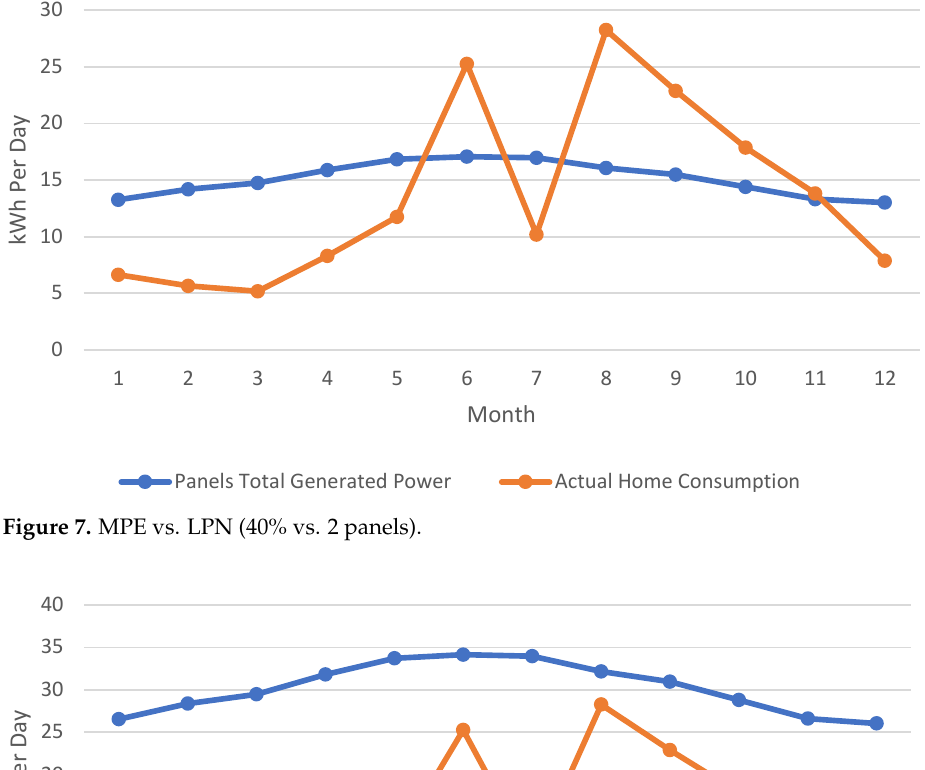
Figure 7. MPE vs. LPN (40% vs. 2 panels).